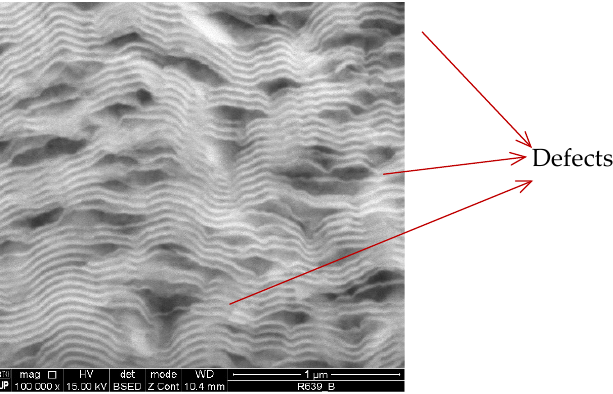
Figure 3. BSE SEM cross-section micrograph of an Al/Ni thin film with a period close to 50 nm deposited onto a W wire ( φ = 0.20 mm).